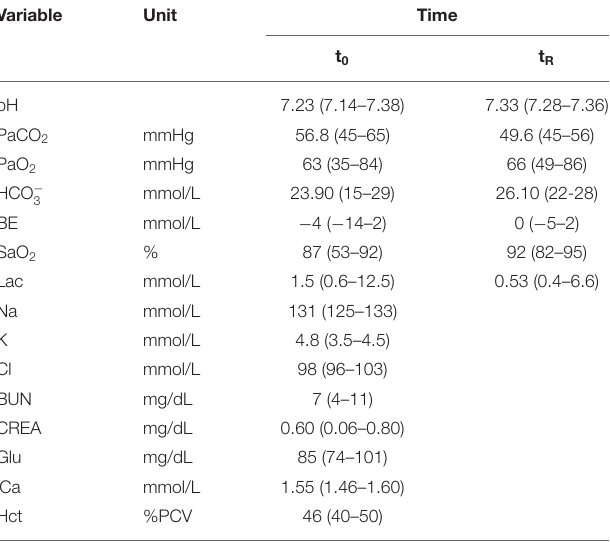
TABLE 2 | PH, partial pressure of carbon dioxide (PaCO 2 ), pressure of oxygen (PaO 2 ), base excess (BE), bicarbonate (HCO − 3 ), hemoglobin oxygen saturation (SaO 2 ) and lactate (Lac) at first handling (t 0 ) and reversal (t R ) of seven black rhinoceroses anesthetized in this study with etorphine-medetomidine-midazolam; Blood chemistry parameters of seven black rhinoceroses at t 0 : sodium (Na), potassium (K), chloride (Cl), ionized calcium (iCa), Glucose (Glu), urea (BUN), creatinine (Crea), and hematocrit